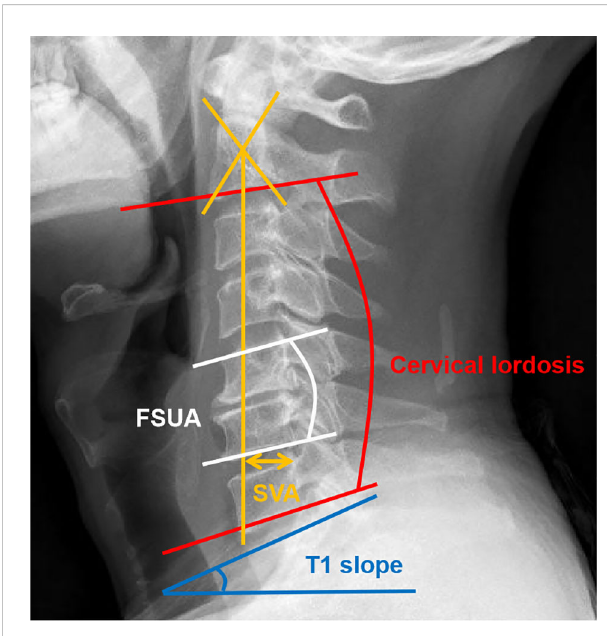
FIGURE 1 Measurements of the cervical sagittal alignment parameters. (1) Red line: cervical lordosis (CL); (2) yellow line: sagittal vertical axis (SVA); (3) white line: functional spine unit angle (FSUA); (4) blue line: T1 slope (TS).